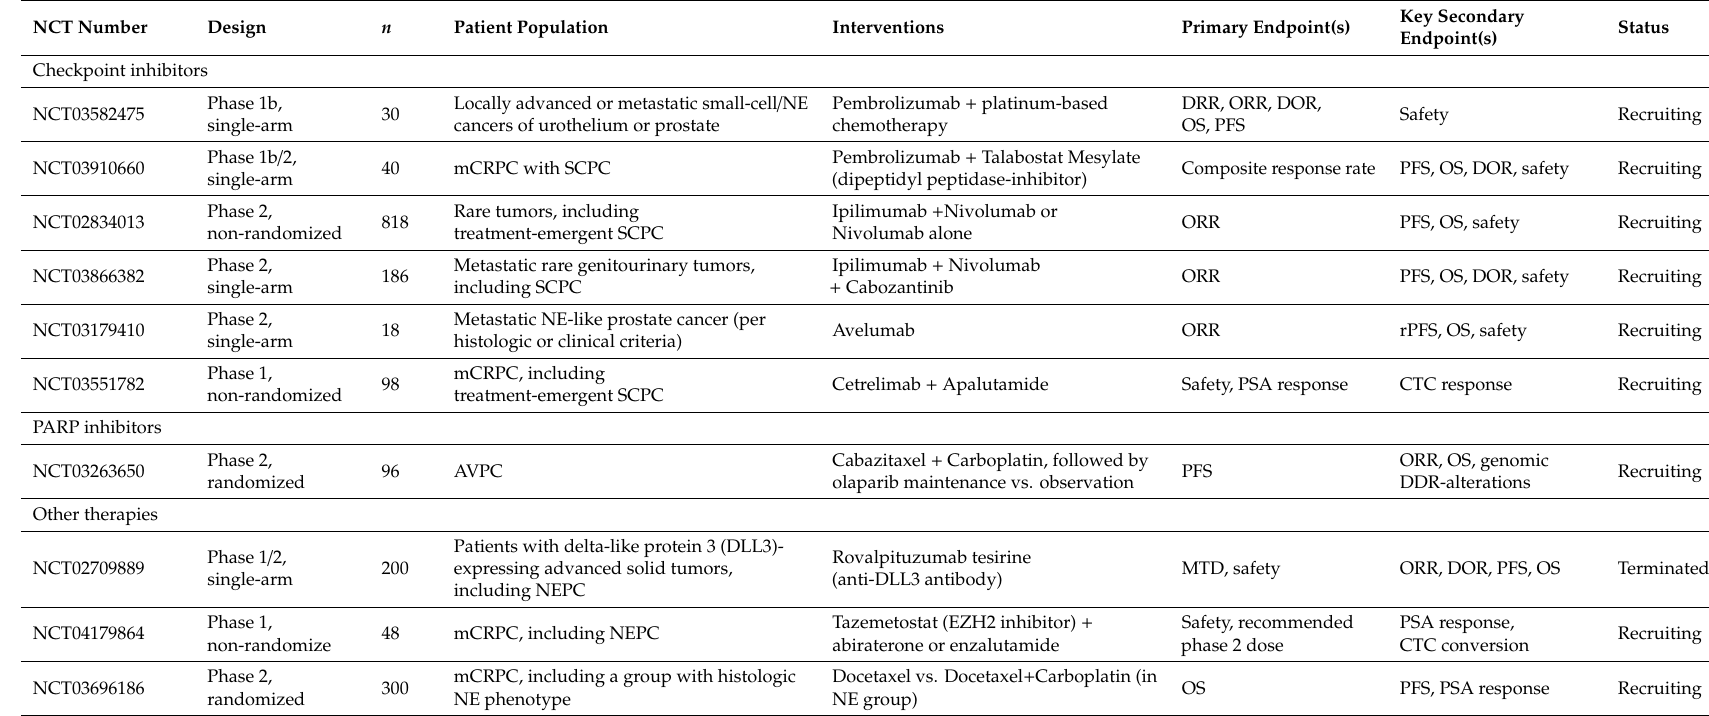
Table 4. Ongoing interventional studies in